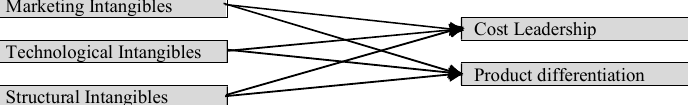
Fig. 1. The proposed conceptual